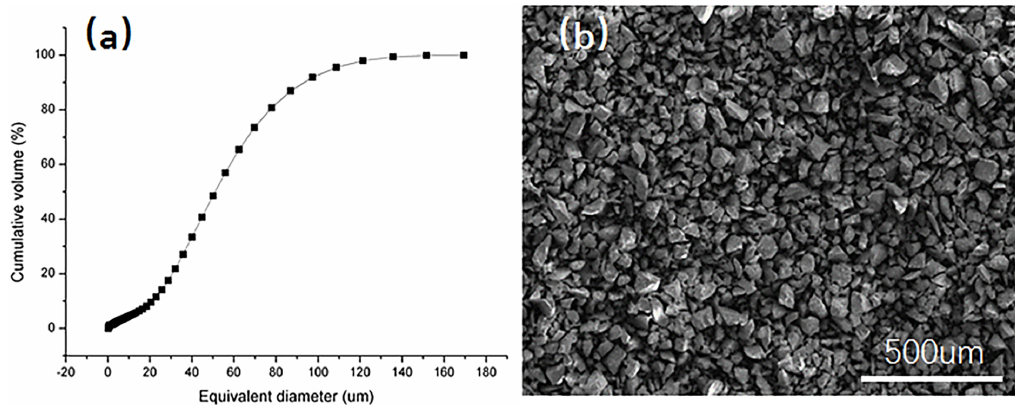
Figure 1. ( a ) Equivalent diameter distribution and ( b ) morphology of feeding powders.